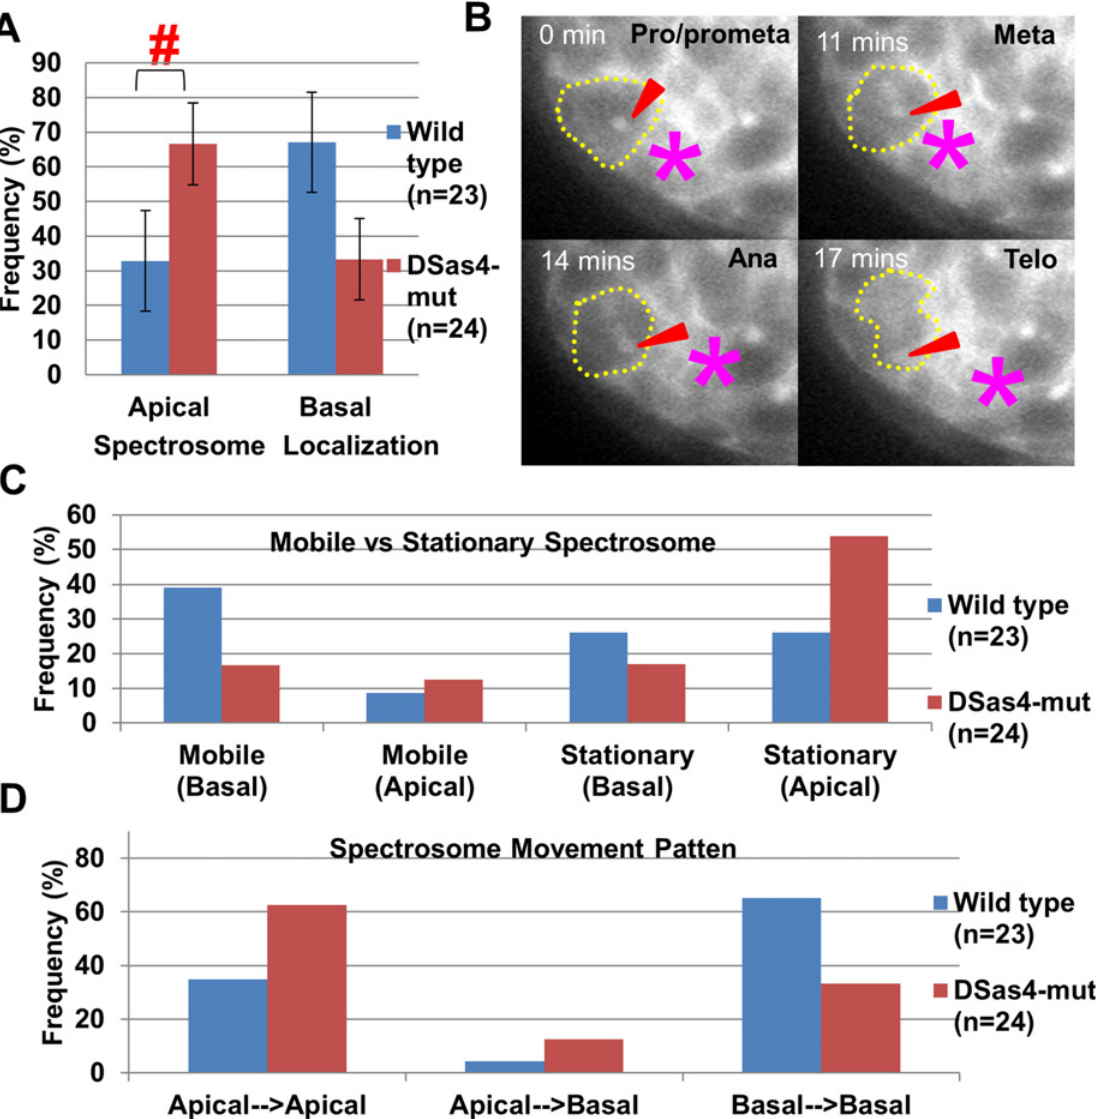
Fig 2. Dynamic migration patterns of spectrosomes are quantified utilizing time-lapse live-imaging. (A) Spectrosome localization in DSas4-mut becomes predominantly apical compared to wild type. #: p < 0.05. (B) Live image sequences shows apically (to the hub cells) migrating spectrosome in a dividing DSas4-mut GSC. Arrowhead: spectrosome. * : hub cells. Yellow dash-line: GSC. (C) In wild type GSCs, large majority of spectrosomes were mobile and located basally (39%) during interphase. In DSas4-mut GSCs, majority of spectrosomes were stationary and located apically (54%). Wild type: n = 23, DSas4-mut: n = 24. (D) DSas4-mut GSCs had higher percentage of spectrosomes migrating from apical to the basal side prior to mitosis. Spectrosome switches are categorized as such if they migrate within 30 mins prior to mitosis (identified by nuclear envelope breakdown).